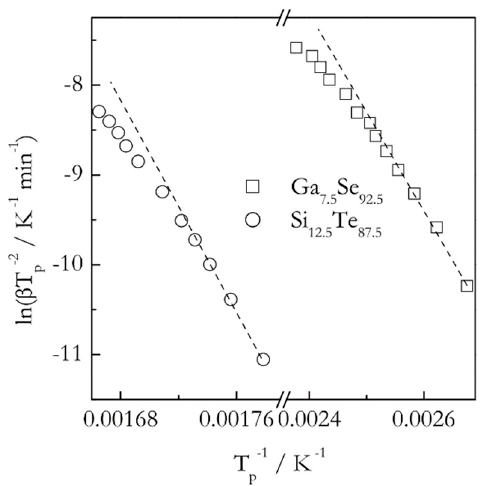
Figure 5. Kissinger plots for crystallization of Ga 7.5 Se 92.5 (squares) and Si 12.5 Te 87.5 (circles) glasses. Dash lines connecting three lowest temperature points are a guide for the eye to better visualize the nonlinearity. The heating rates range from 5 to 90 °C min − 1 . Data from Abu El-Oyoun [41,42].